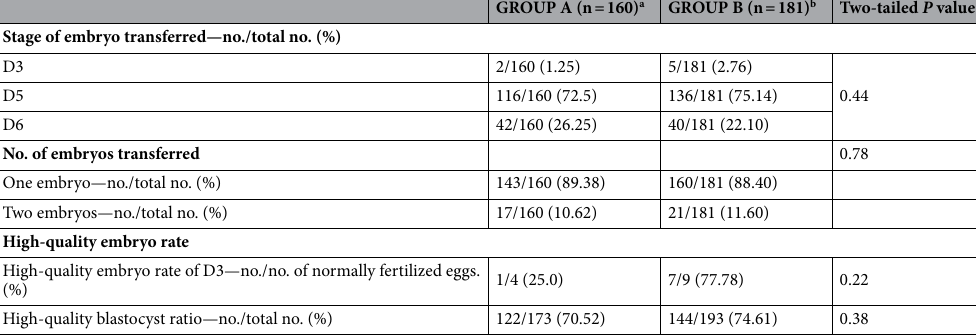
Table 2. Comparison of embryological characteristics of the two groups. a In the study group (n = 160), GnRH-a was added based on GnRH-a before hormone administration to adjust the menstruation cycle. b The control group (n = 181) was treated only with an artificial hormone cycle to prepare the endometrium.